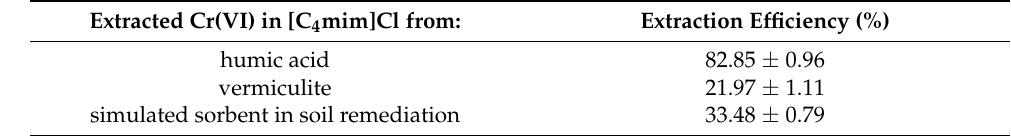
Table 3. Extraction efficiencies of Cr(VI) from sorbents into [C 4 mim]Cl. Extracted Cr(VI) in [C 4 mim]Cl